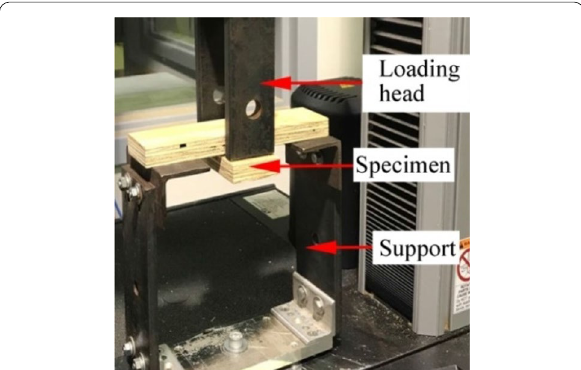
Fig. 8 Test setup for evaluating the load–displacement behavior of direct withdrawal loads of single staple from pine plywood test